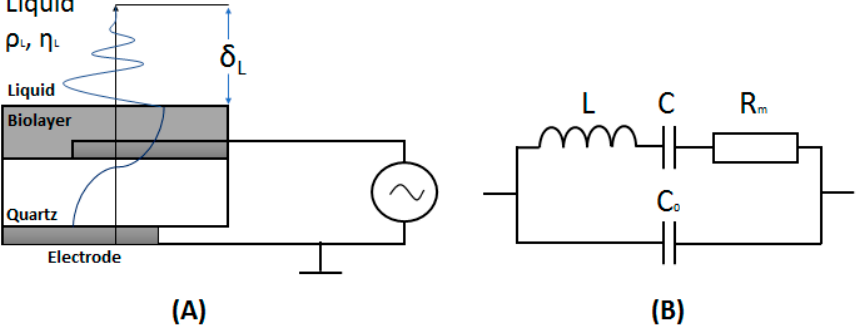
Figure 5. ( A ) Scheme of the propagation of the acoustic wave. η L and ρ L are the viscosity and density of liquid, respectively. δ is penetration depth. ( B ) Butterworth–van Dyke (BvD) equivalent circuit [45].